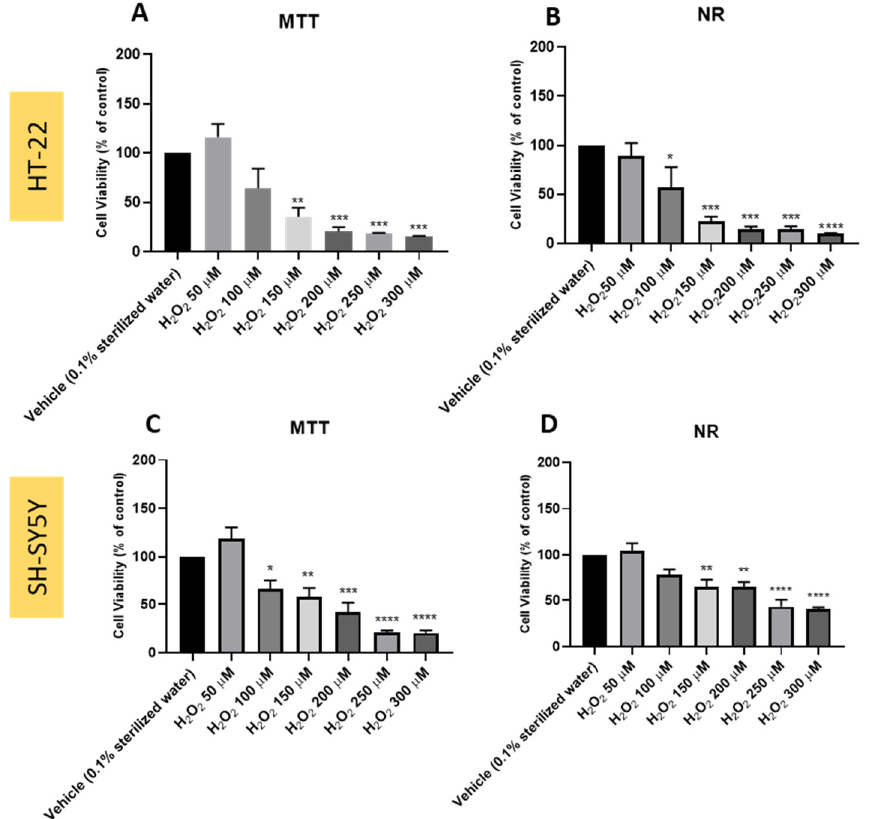
Figure 1. Effect of 48 h-incubation of 50–300 µ M of H 2 O 2 on the viability of HT-22 and SH-SY5Y cells, determined by ( A , C ) MTT and ( B , D ) NR methodologies. The results represent the mean ± SEM of 3–6 independent experiments, expressed as the percentage of the vehicle (100%). Statistically significant * p < 0.05, ** p < 0.01, *** p < 0.001, and **** p < 0.0001 vs. vehicle.